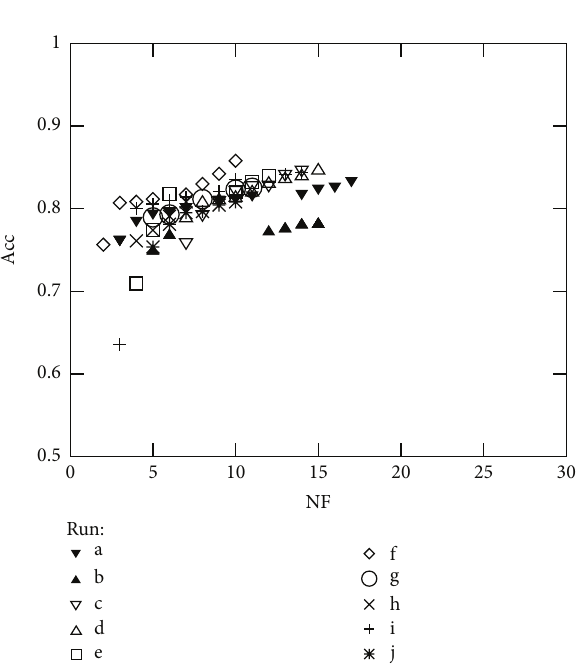
Figure 4: All runs of Experiment 2 (nondominated solutions of the final